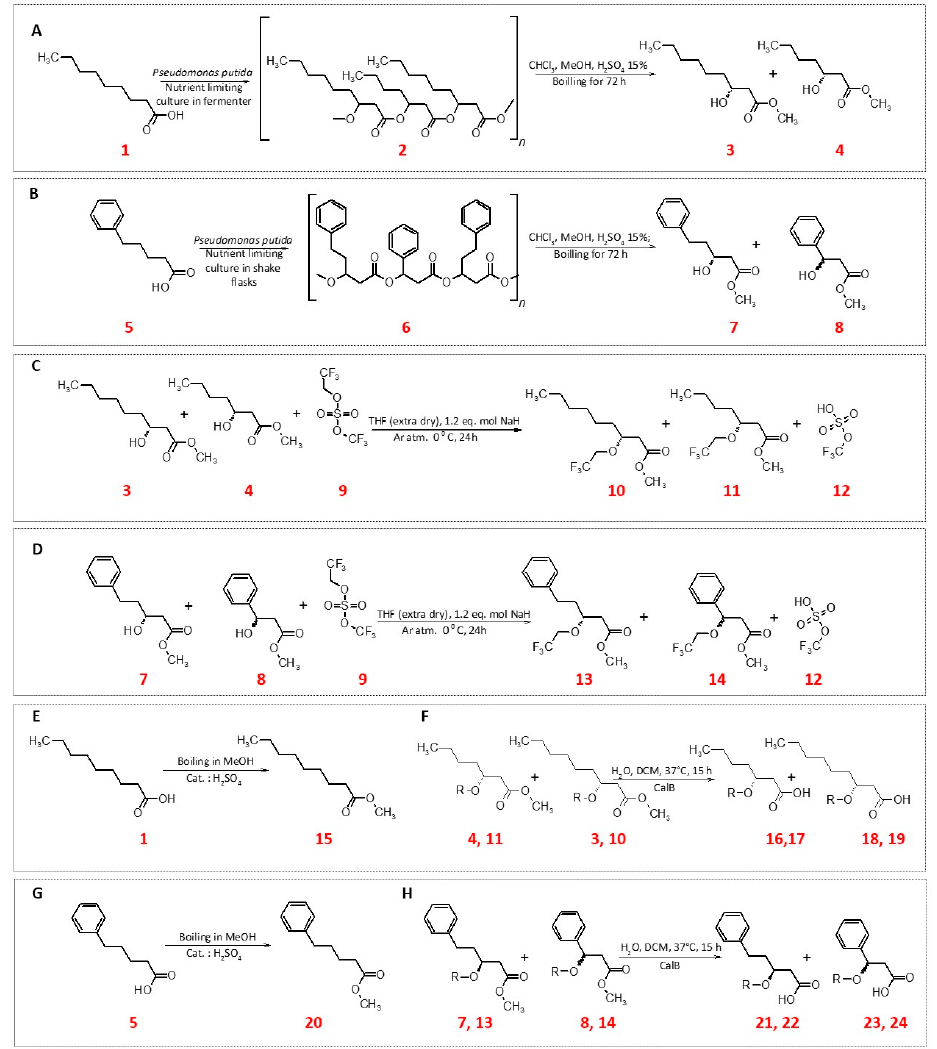
Figure 1. Scheme of synthesis PHA and modifications their monomers (A+B: PHN synthesis and methanolysis; C+D: Fluorination of PHN monomers E+G: methyl ester synthesis; F+H: demethylation of substrates with CalB); 1. nonanoic acid; 2. poly-3-hydroxyhydroxynonaoate; 3. methyl (3R)-3-hydroxynonanoate; 4. methyl (3R)-3-hydroxyheptanoate; 5. 5-phenylpentanoic acid; 6. poly-3-